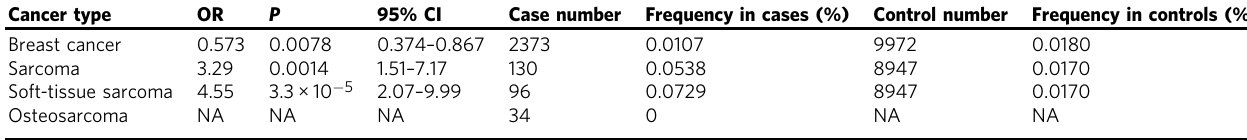
OR odds ratio, CI con fi dence interval, NA not applicable Controls were patients who were not diagnosed with any